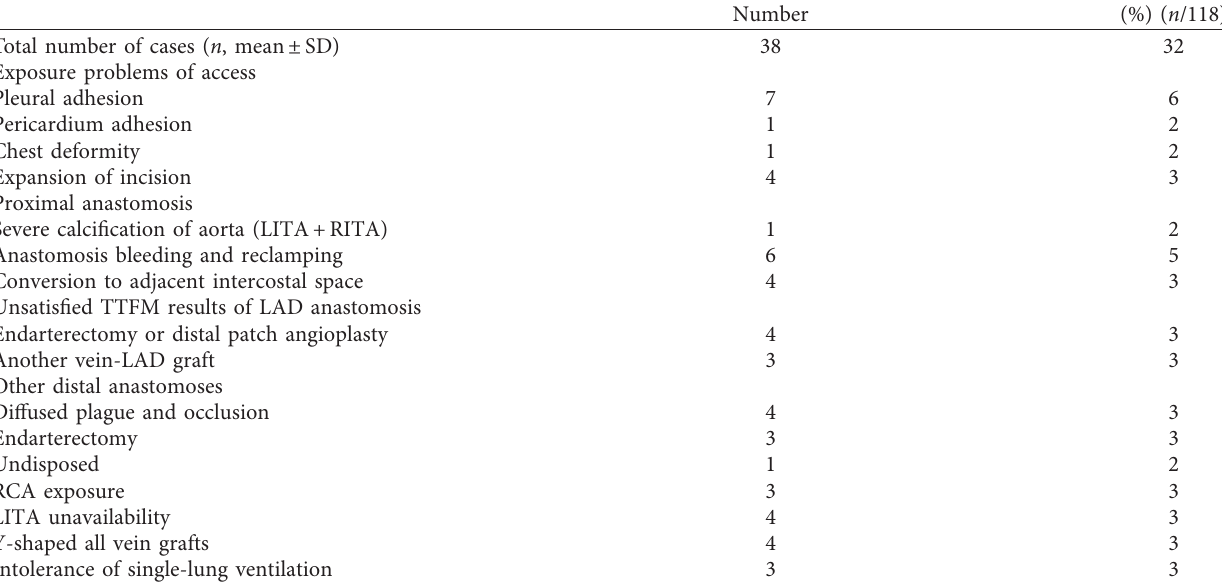
Figure 1: Surgical procedure. (a) LITA retractor (Thoratrak MIC S retractor system) was used to expose the chest wall space for LITA takedown. (b) Vein-aorta exposure and proximal anastomosis. (c) Vein to obtuse marginal branch anastomosis. (d) Vein to posterior descending artery Table 1: Surgical challenges and clinical incidence ( n � 118).